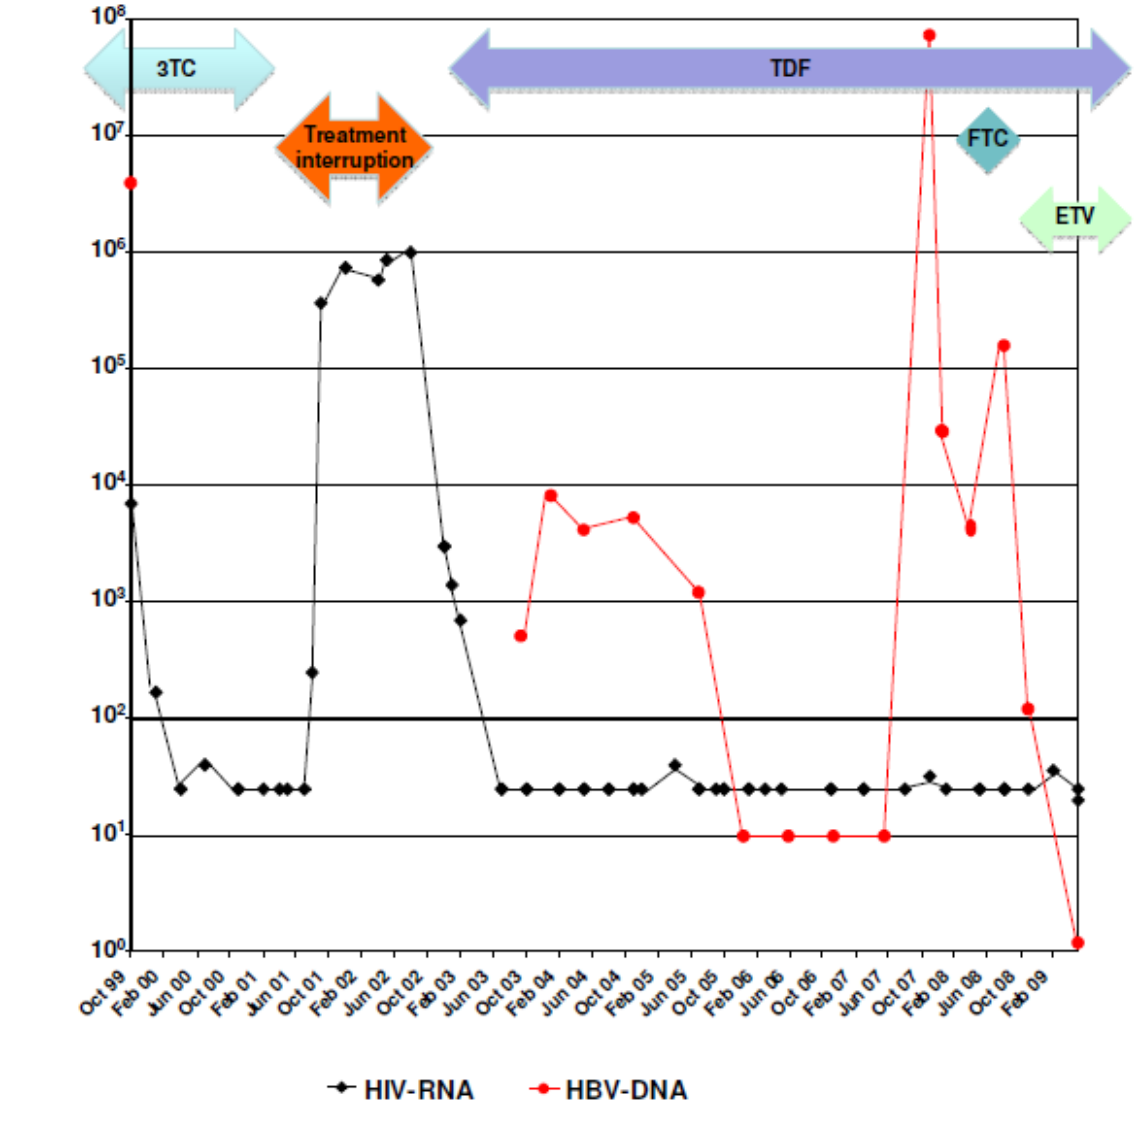
Figure 2. Course of viremia of both HIV-RNA and HBV-DNA (genome copies per ml plasma) throughout the observation period. 3TC: Lamivudine; TI: Treatment